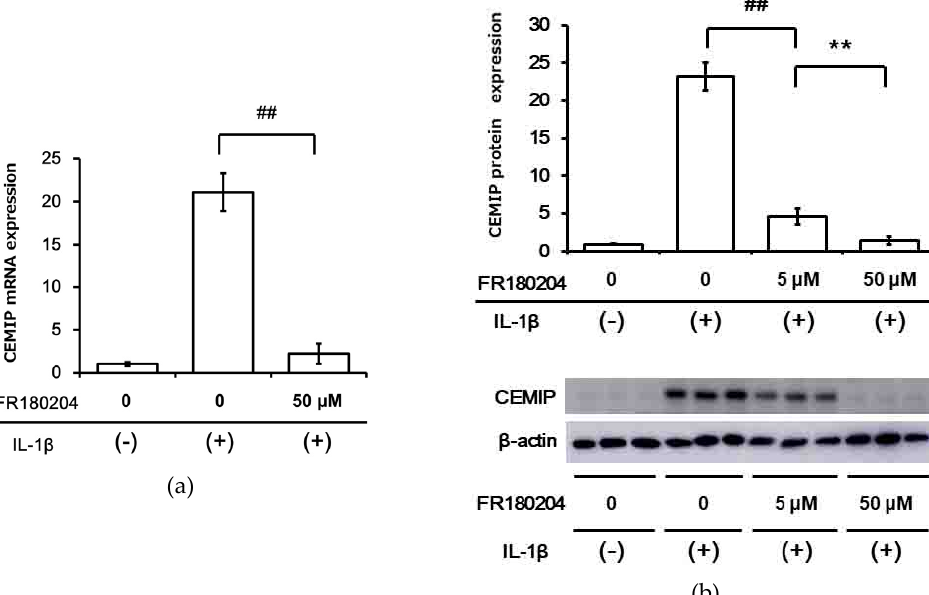
Figure 5. ERK inhibitor attenuated IL-1 β -induced CEMIP expression in OUMS-27 cells. ( a ) ERK inhibitor (FR180204, 50 μ M) was added 1 h prior to IL-1 β stimulation and CEMIP mRNA expression was analyzed 12 h after treatment with IL-1 β . ( b ) FR180204 attenuated IL-1 β -induced CEMIP protein expression at 12 h in a dose-dependent manner. Values represent mean ± SD ( n = 6 per group). ## p < 0.01 vs. IL-1 β -treated group. ** p < 0.01 vs. IL-1 β with low dose (5 μ M) FR180204 treated group. Int. J. Mol. Sci. 2018 , 19 , x